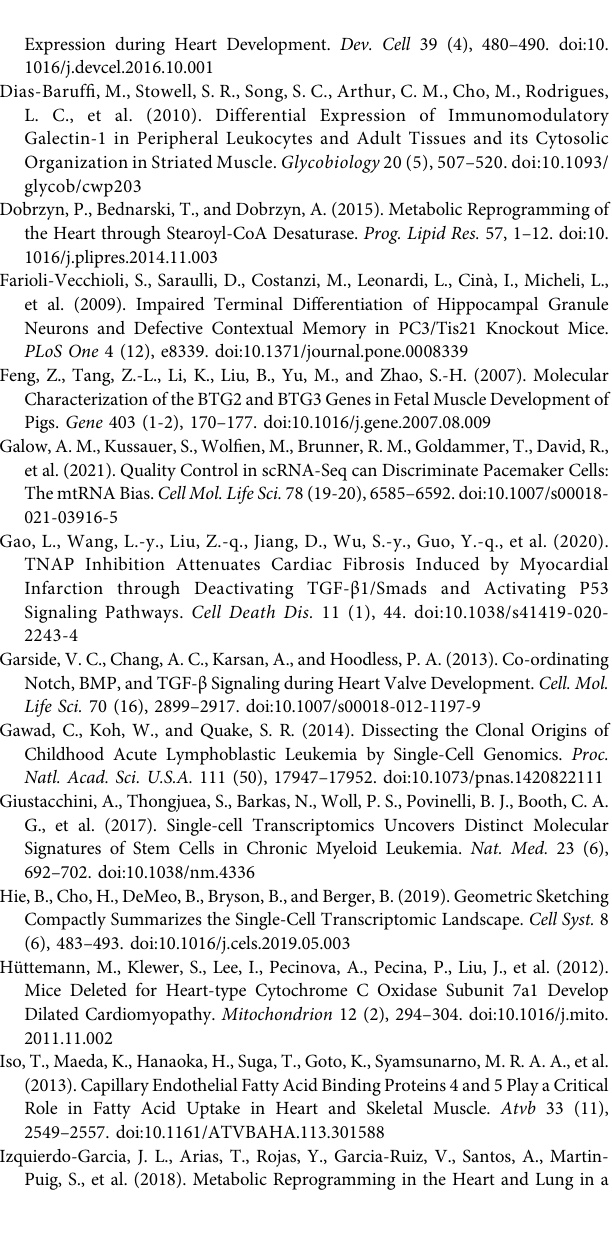
Supplementary Figure S2 | Construction of pseudotemporal trajectory of human and mouse cardiomyocytes. (A) Heatmap showing the molecular characteristics of each cardiomyocyte subpopulation (human: H, left; mouse: M, right). (B) Pseudotemporal trajectory of CM subpopulations constructed by Monocle2 colored by developmental stage (human: H, top; mouse: M, bottom). (C) Violin plots showing the expression of LGALS1, ANXA3, SCD in CM subclusters (human: left; mouse: right). Supplementary Figure S3 | Construction of pseudotemporal trajectory of human and mouse fi broblasts. (A) Heatmap showing the molecular characteristics of each fi broblast subpopulation (human: H, left; mouse: M, right). (B) Pseudotemporal trajectoryofFBsubpopulationsconstructedbyMonocle2coloredbydevelopmental stage(human:H,top;mouse: M, bottom). (C) Violin plotsshowingtheexpression of RGS5, BTG2 in FB subclusters (human: left; mouse: right).